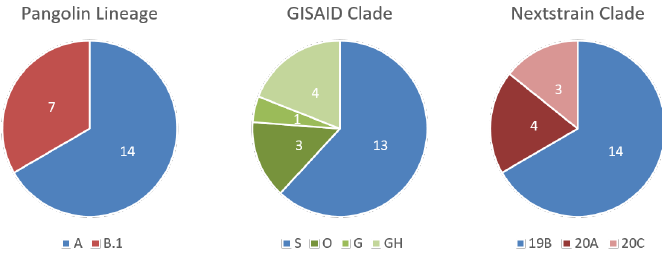
Figure 3. Sample assignment according to di ff erent nomenclatures used for SARS-CoV-2-classification.